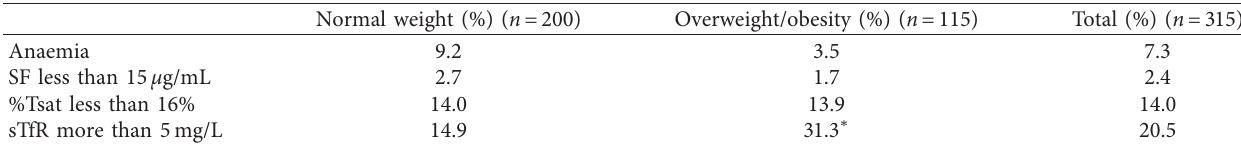
Table 2: Prevalence of iron deficiency and anaemia using different